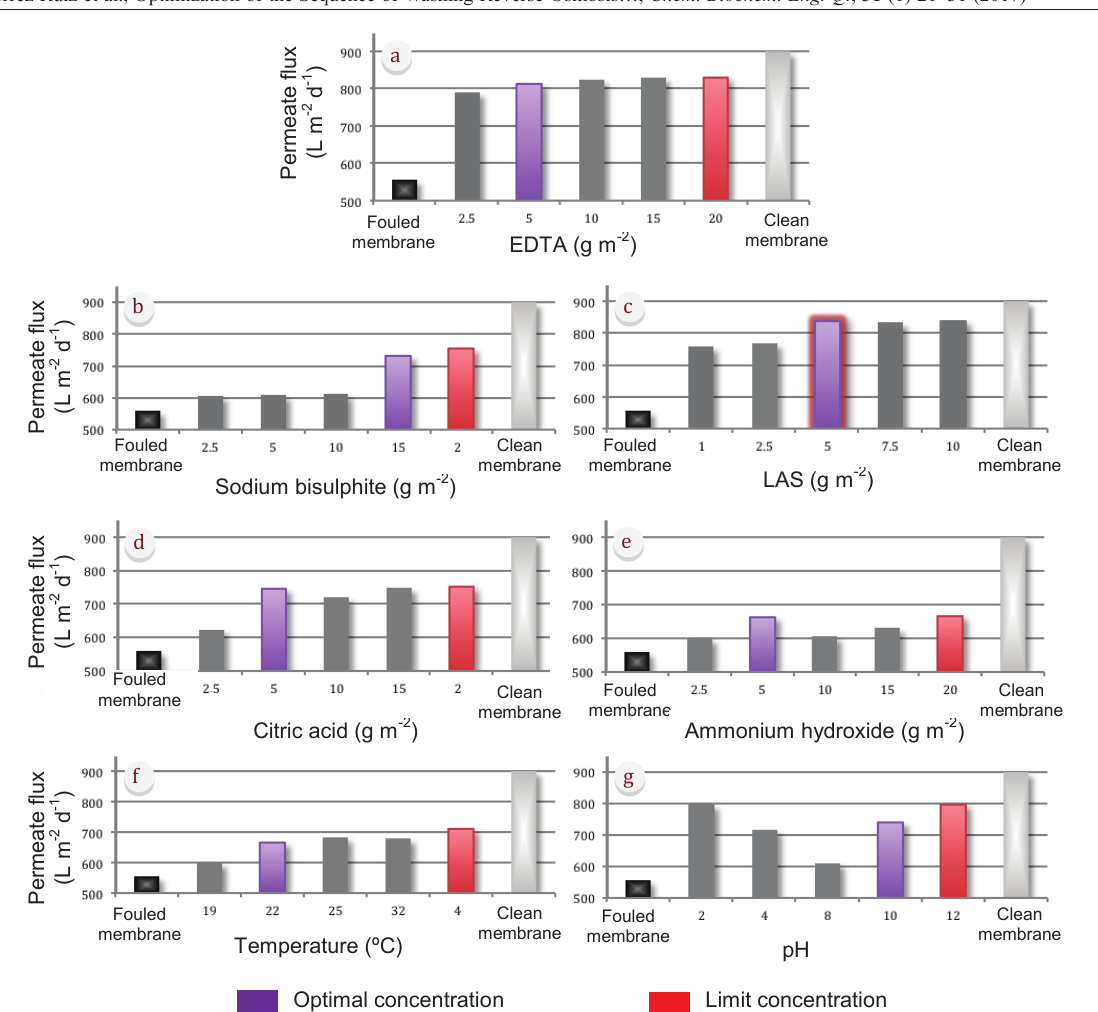
Fig. 5 – Evolution of normalized permeate flux in the cleaning trials with different concentrations of